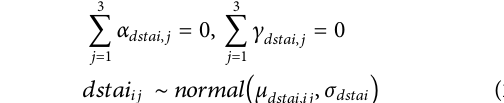
Frontiers in Virtual Reality |